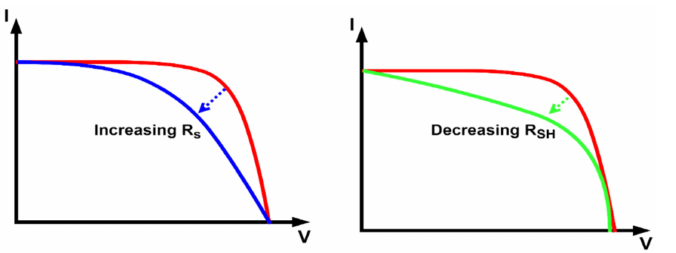
Figure 2. I-V Curve for PV Arrays.